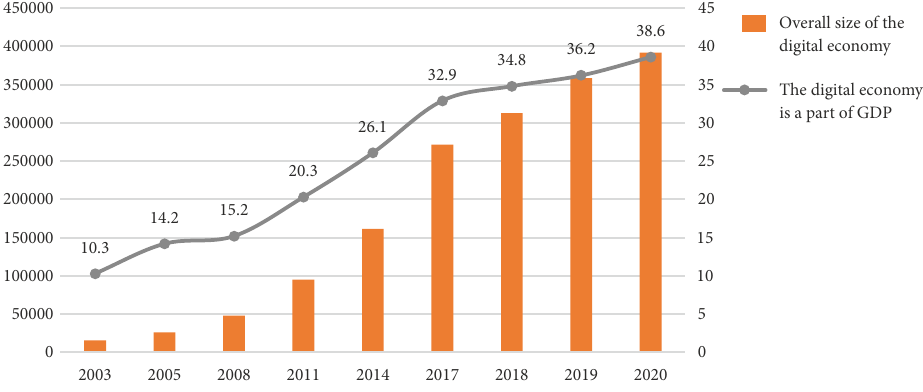
Figure 1. Overall scale and proportion of Chinese digital economy in GDP in 2003–2020